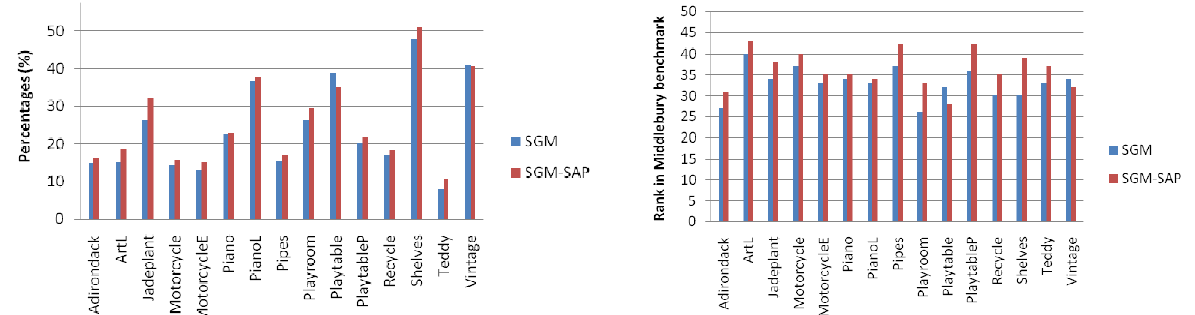
Figure 3. Errors for all stereo-pairs (left) and ranking in Middlebury benchmark (right) for SGM and our method (SGM-SAP).